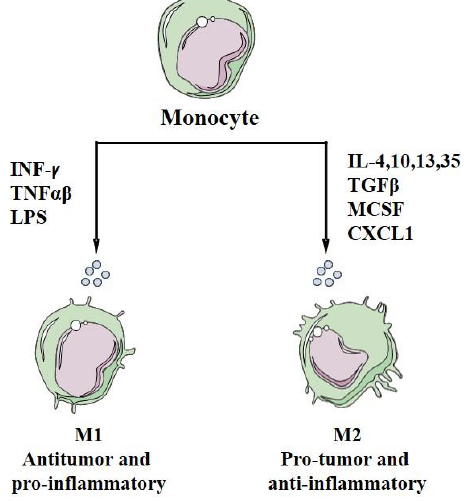
Figure 2. Differentiation of monocytes into macrophages M1 and M2.